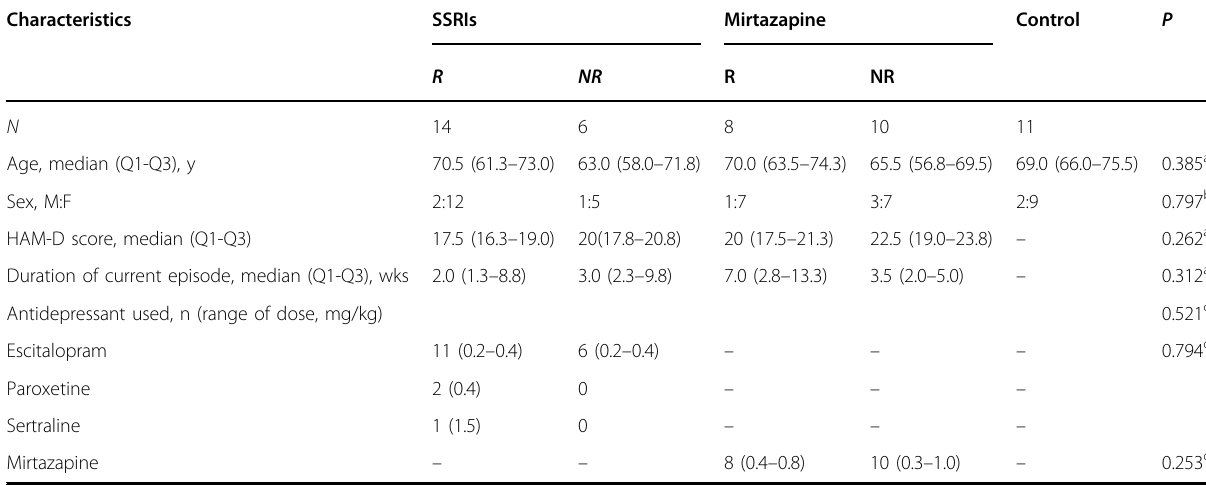
Table 1 Characteristics of healthy controls and major depressive disorder patients at baseline Characteristics